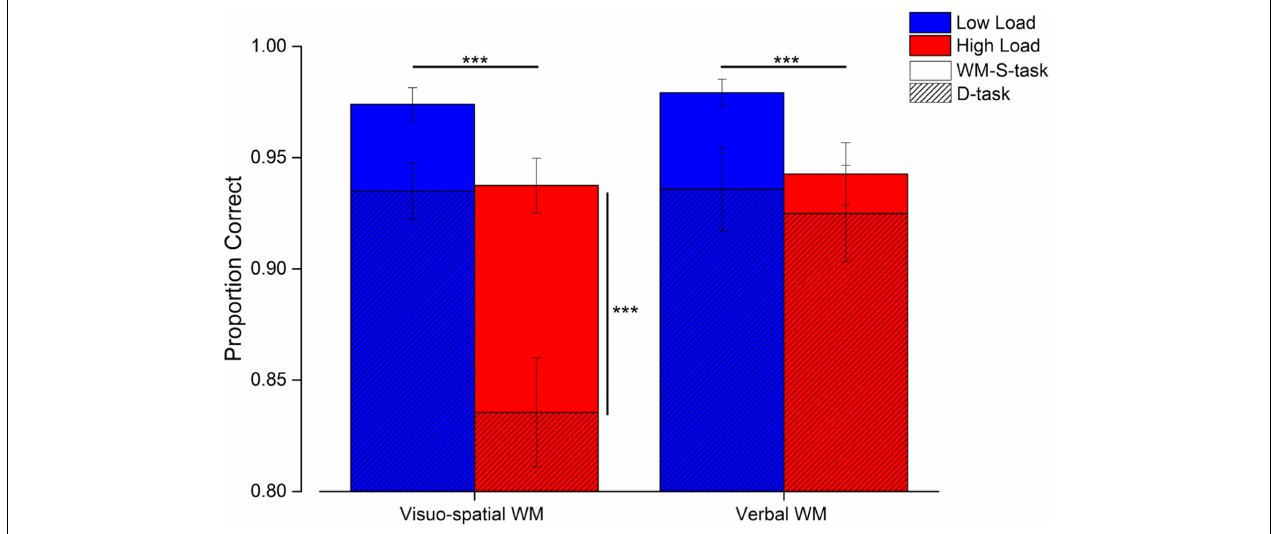
FIGURE 5 | Results of the working memory tasks. Average performance in the working memory tasks in the single (solid bars) and dual tasks (hatched bars) for both the low (blue) and high (red) load trials. Error bars are SEM. *** p < 0.005.